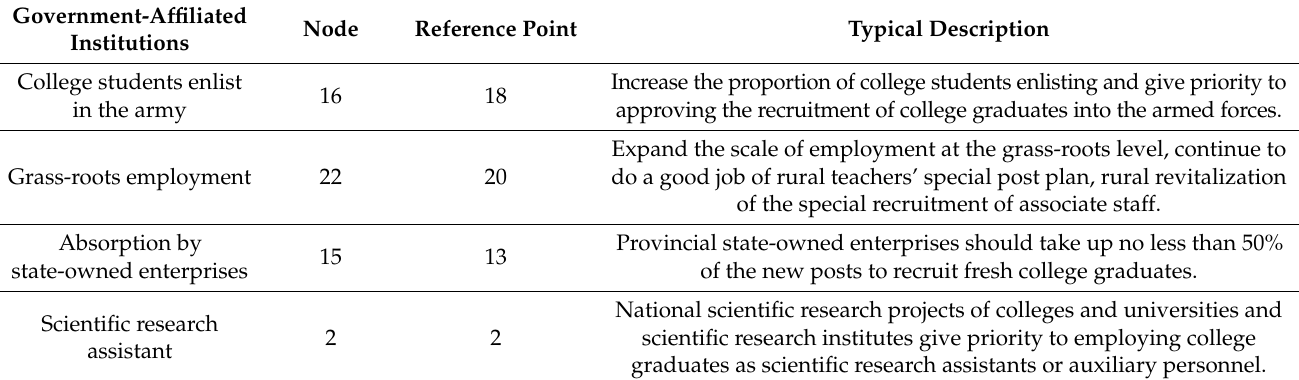
Table 3. Absorption measures of public